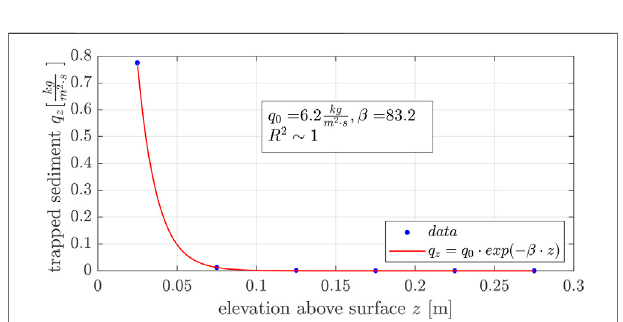
FIGURE9 | Vertical distribution of sediment transport fl ux obtained from the vertical mesh sand trap for wind velocity u 3 = 9.3 m/s and the best fi t exponential decay function for experiment No.